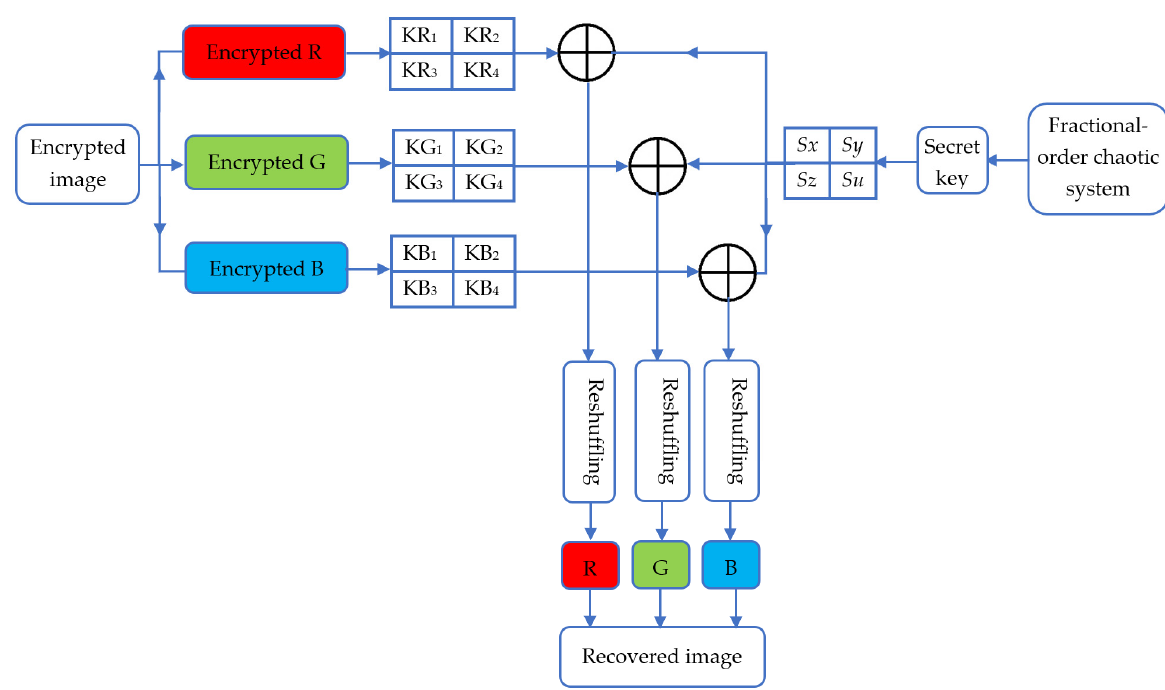
Figure 14. Block diagram of the decryption algorithm.